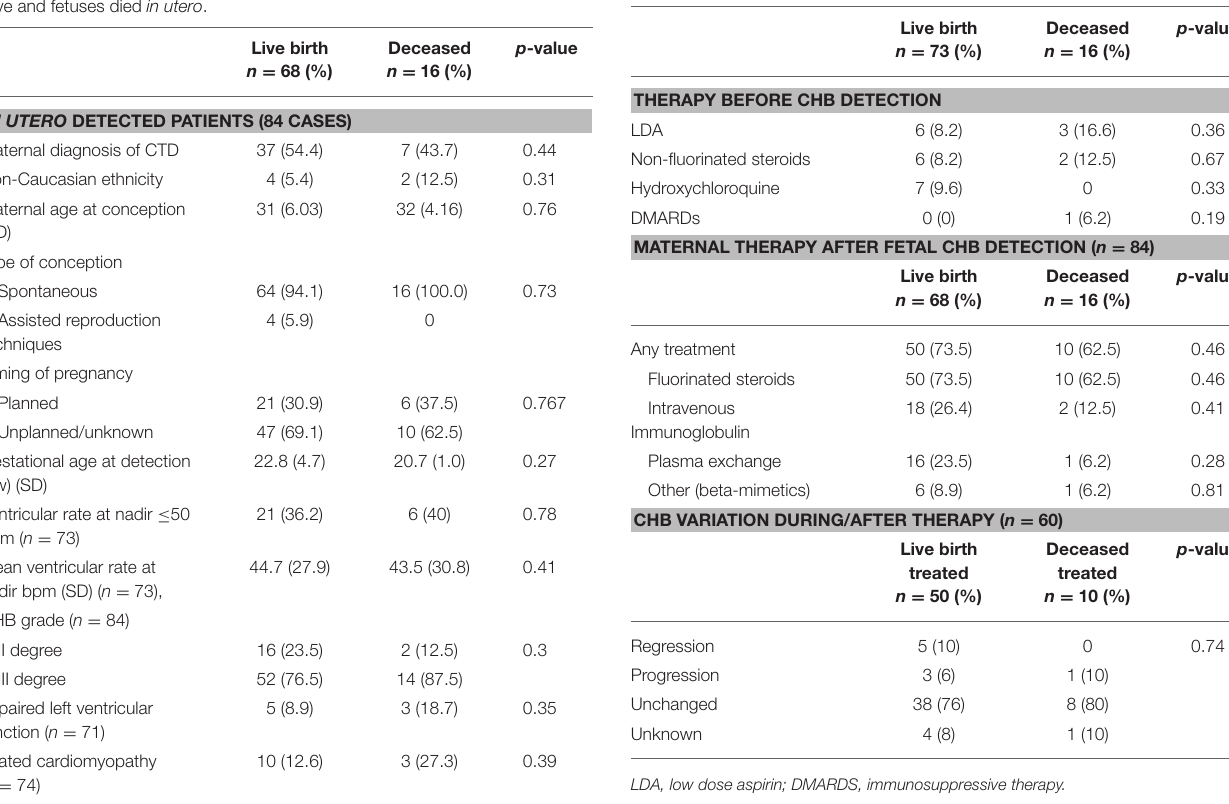
TABLE 5 | Therapy before and after CHB detection. p -value Live birth Deceased n = 68 (%) n = 16 (%)